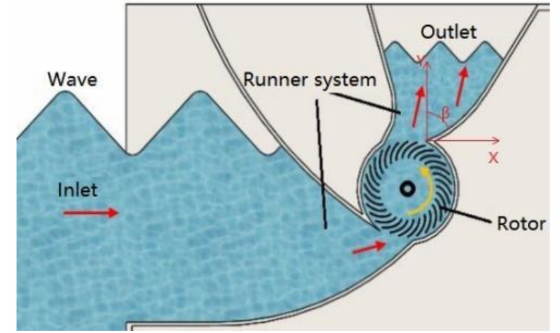
Figure 1. Cutaway view of the device [45,49].